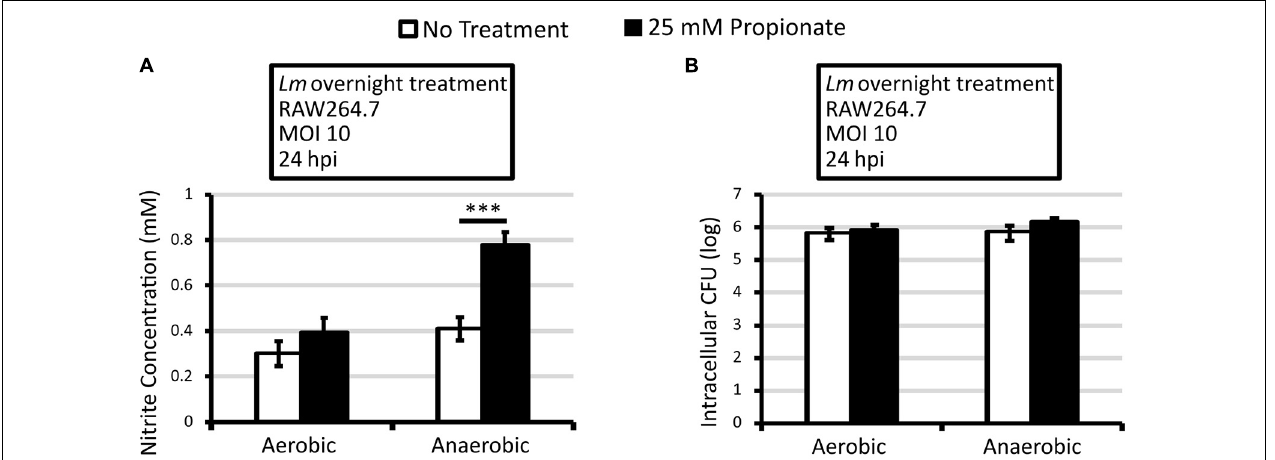
FIGURE 2 | Macrophages infected with L. monocytogenes grown anaerobically with propionate pretreatment produce higher levels of NO. Overnight cultures of L. monocytogenes were washed and used to infect RAW264.7 macrophages for 30 min. No propionate was present during infections. Nitrite concentration (A) and intracellular CFU (B) were measured at 24 hpi. Averages of 9 replicates across 3 independent experiments were plotted with error bars representing standard errors of the mean. Asterisks denote statistical significance between pair-wise comparisons with ∗∗∗ p < 0.001.